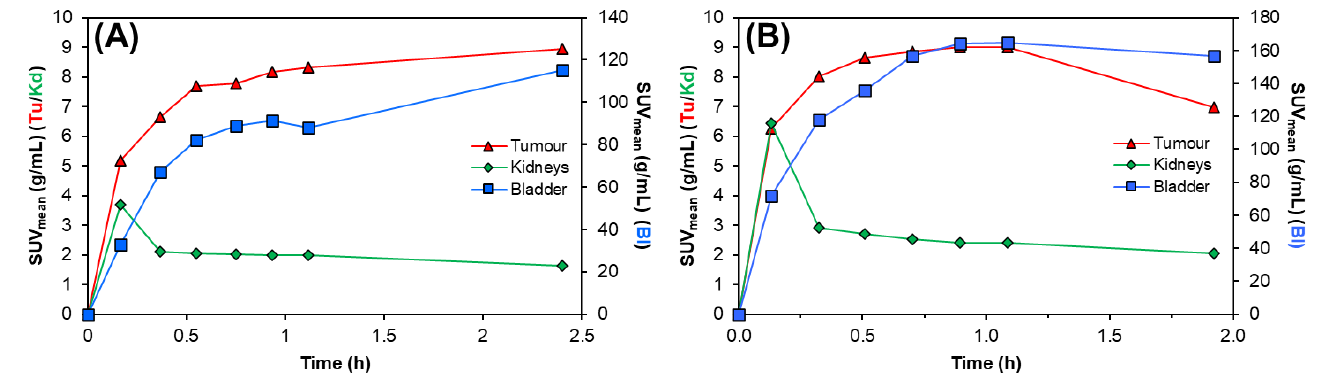
Figure 5. Representative time–activity curves for (A) [ 155 Tb]Tb - crown - TATE (13.8 MBq, 0.71 nmol) and (B) [ 161 Tb]Tb - crown - TATE (7.95 MBq, 0.70 nmol) in male NRG mice bearing AR42J tumour xenografts. Tu: Tumour; Kd: Kidneys; Ad: Adrenal glands; Bl: Bladder.